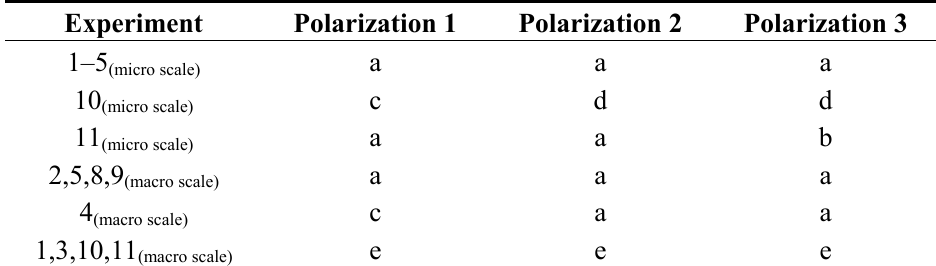
Table 3. Overview of the EIS experiments with their electrochemical equivalent circuits shown in Figure 8.